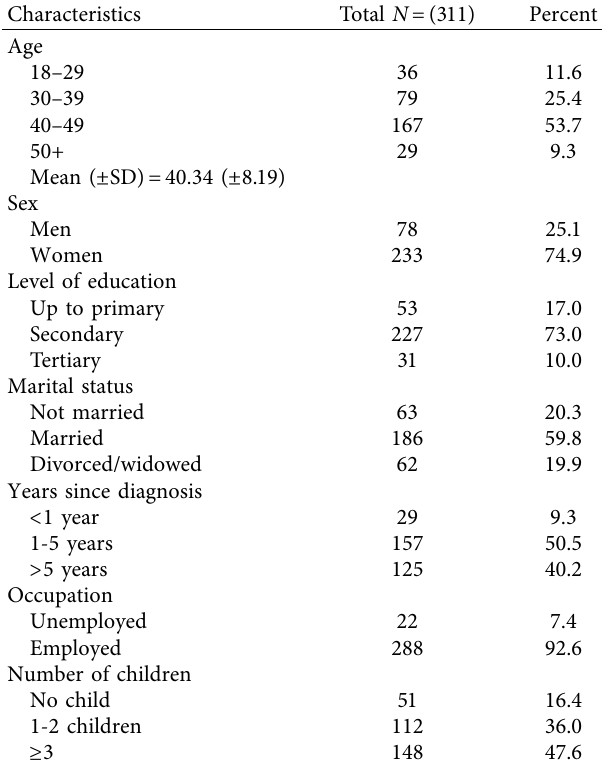
Table 1: Sociodemographic characteristics of participants.